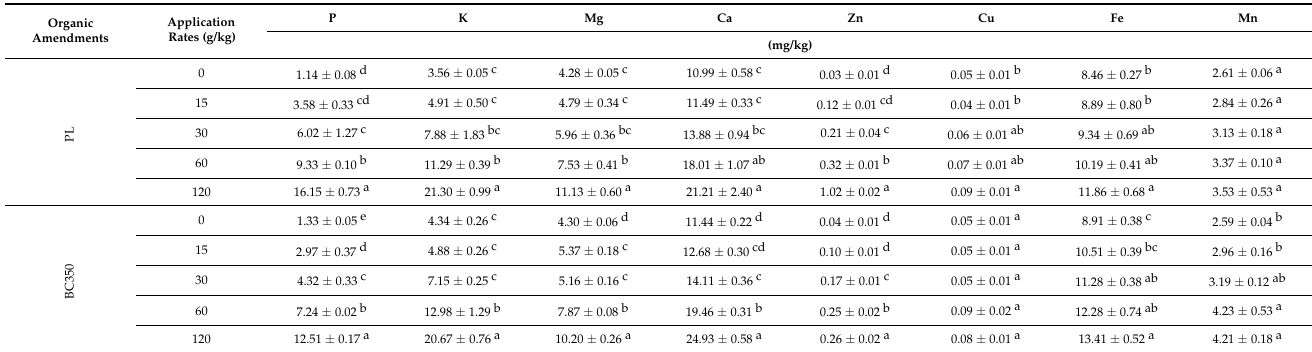
Table 3. Available plant nutrient concentrations in soils incorporated with different application rates of poultry litter and its biochar at harvest.